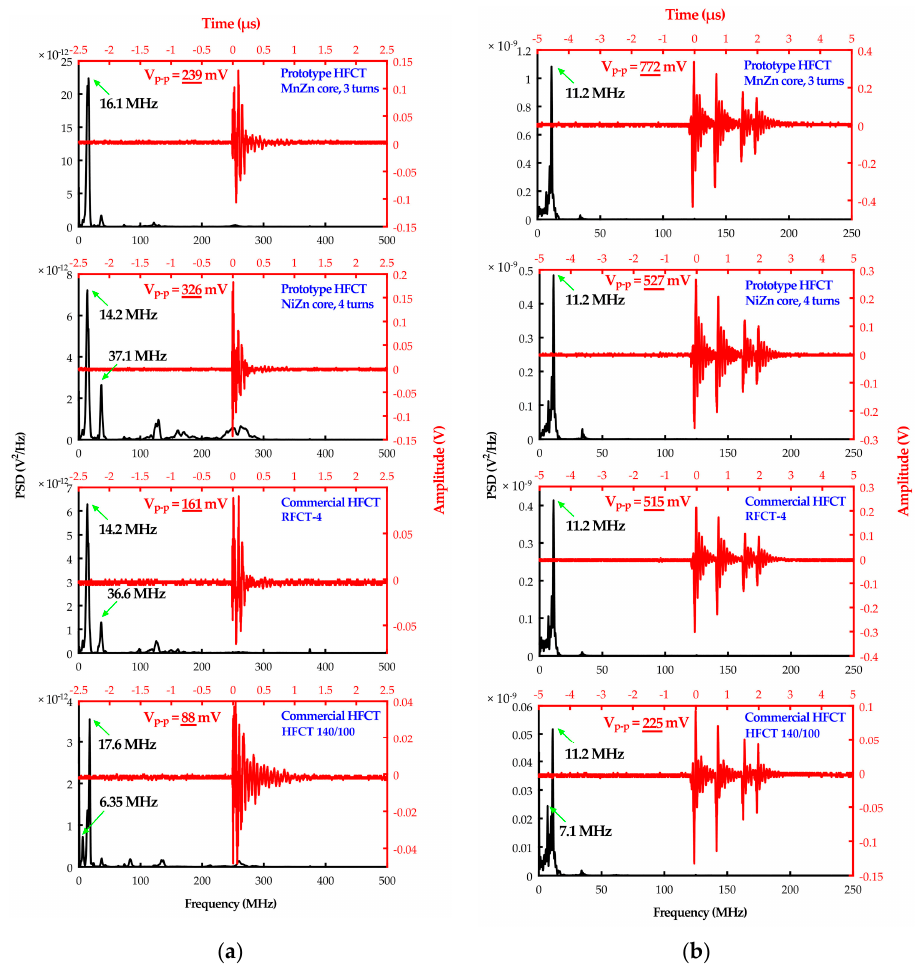
Figure 19. Comparison of typical partial discharge time waveforms and power spectral density (PSD) characteristics registered for ( a ) PD in oil, and ( b ) surface PD with the use of selected prototype and commercial (RFCT-4, HFCT 140/100) HFCT sensors.